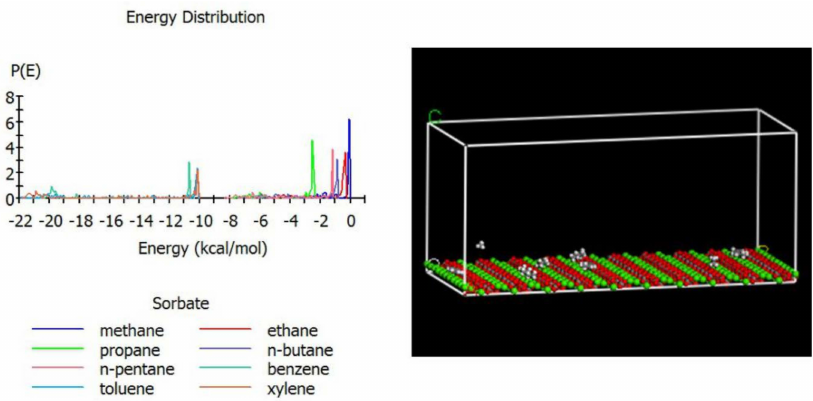
Figure 9. Calculated adsorption energies (kcal/mol) on a calcite surface in a pore space.